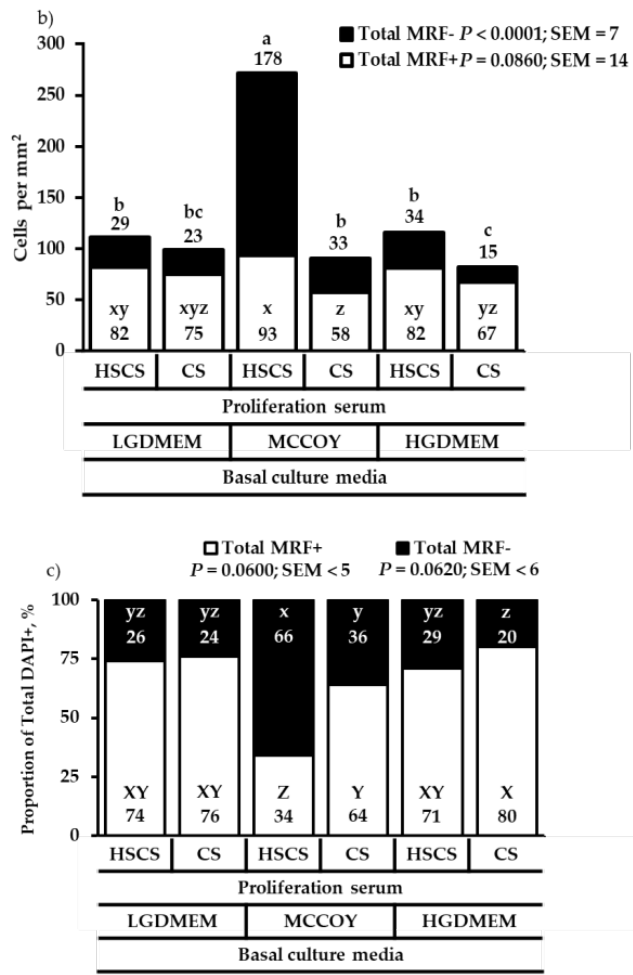
Figure 1. The effect of basal culture media and proliferation sera on total DAPI+ cells ( a ), total MRF+ and total MRF- cells ( b ), and proportions of total MRF+ or total MRF- cells to total DAPI+ cells ( c ) at 48 h post-plating. Cells were cultured in either low glucose Dulbecco’s Modified Eagles medium (LGDMEM), McCoy’s 5A (MCCOY), or high glucose Dulbecco’s Modified Eagles medium (HGDMEM) supplemented with either 5% horse serum + 10% chicken serum (HSCS) or 15% chicken serum (CS). a–c Means with different superscripts describe a difference p < 0.05 and were generated from the pairwise mean comparison analysis. x–z Means with different superscripts describe a tendency 0.0501 ≤ p ≤ 0.10 and were generated from the pairwise mean comparison analysis.